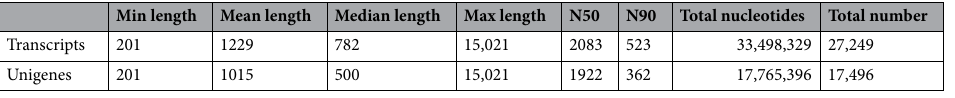
Table 1. Summary of sequence assembly.